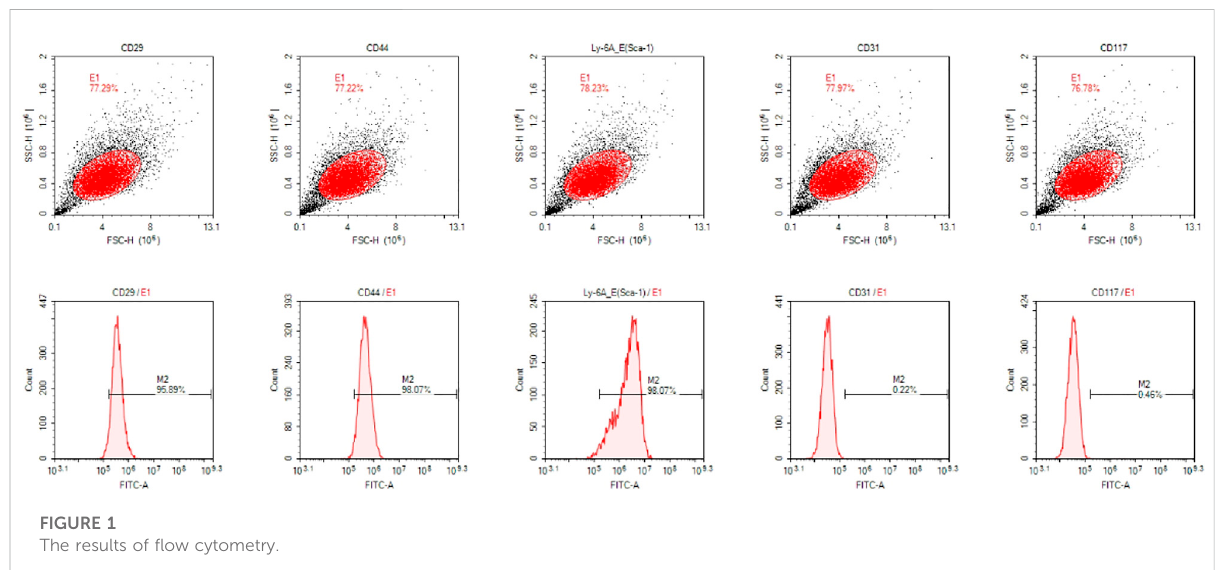
FIGURE 1 The results of fl ow